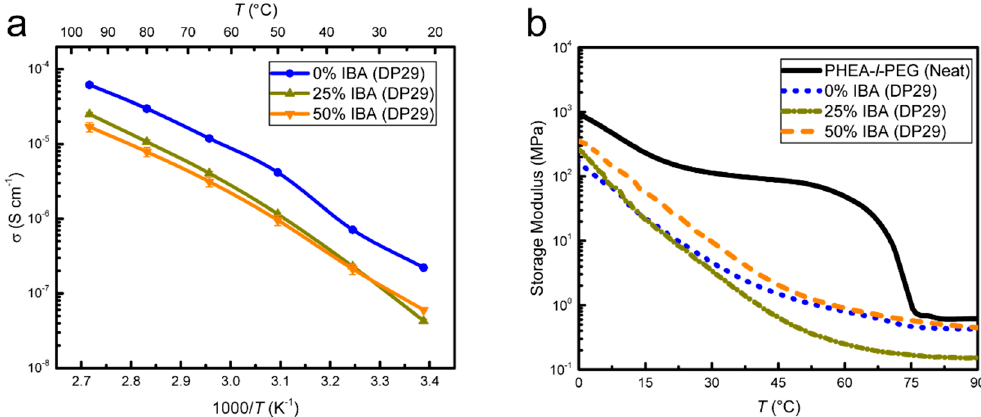
Figure 8. Comparison of SPE-4 with SPE-3 for DP29 and a Li-ion concentration of r = 0.08. ( a ) EIS shows a general increase in conductivity as a function of temperature for all samples, with a lower conductivity for IBA containing electrolytes. ( b ) DMA of SPE-4 shows a decrease in storage modulus (softening) as a function of temperature for all samples.